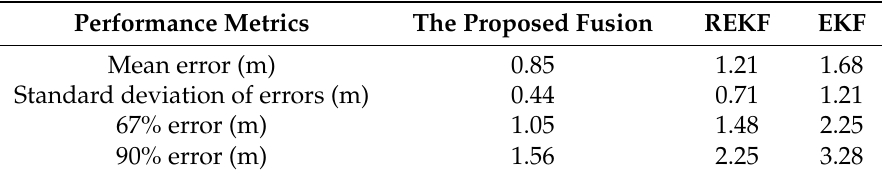
Table 4. Statistical errors of the proposed fusion, REKF, and EKF